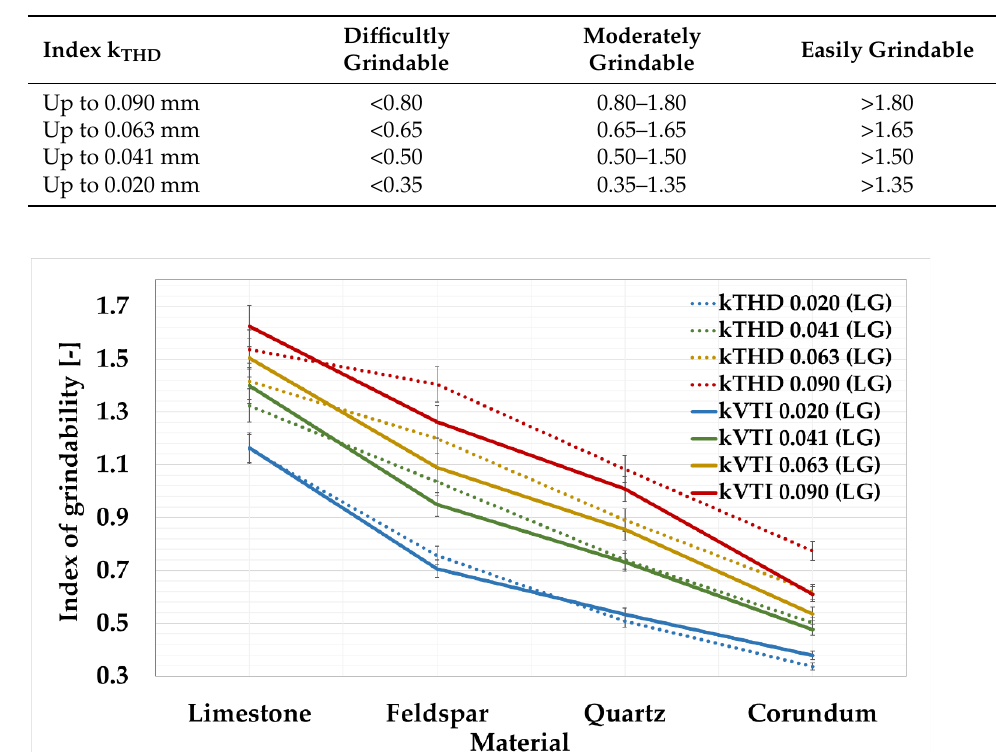
Figure 7. Comparison of grindability indexes by laser granulometry for VTI and THD methods.